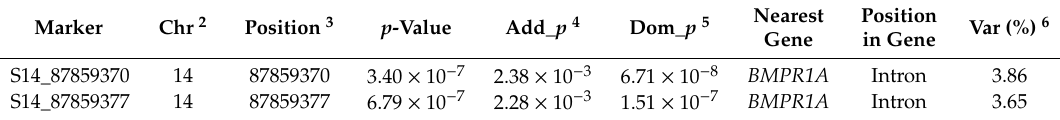
Figure 3. Identification of BMPR1A using conditional GWAS of the NTV. ( A ) Manhattan plot displaying the GWAS results of the NTV. The red horizontal line indicated the Bonferroni significance threshold (1.10 × 10 − 6 ). Dots represent SNPs and the S14_87859370 is highlighted at the top dot. ( B ) The Q-Q plots obtained from the conditional GWAS for the NTV. ( C ) Red arrow represents the most significant SNP signal of the NTV. The S14_87859370 in the intron 4 of BMPR1A is marked in red. ( D ) The di ff erence analysis among three genotypes of S14_87859370 for NTV in Songliao Black (SLB) and Large White (LW) pig populations. * indicates p < 0.05. ( E ) Allele frequencies of S14_87859370 in SLB and LW pig populations. Table 4. Conditional genome-wide association study for the NTV 1